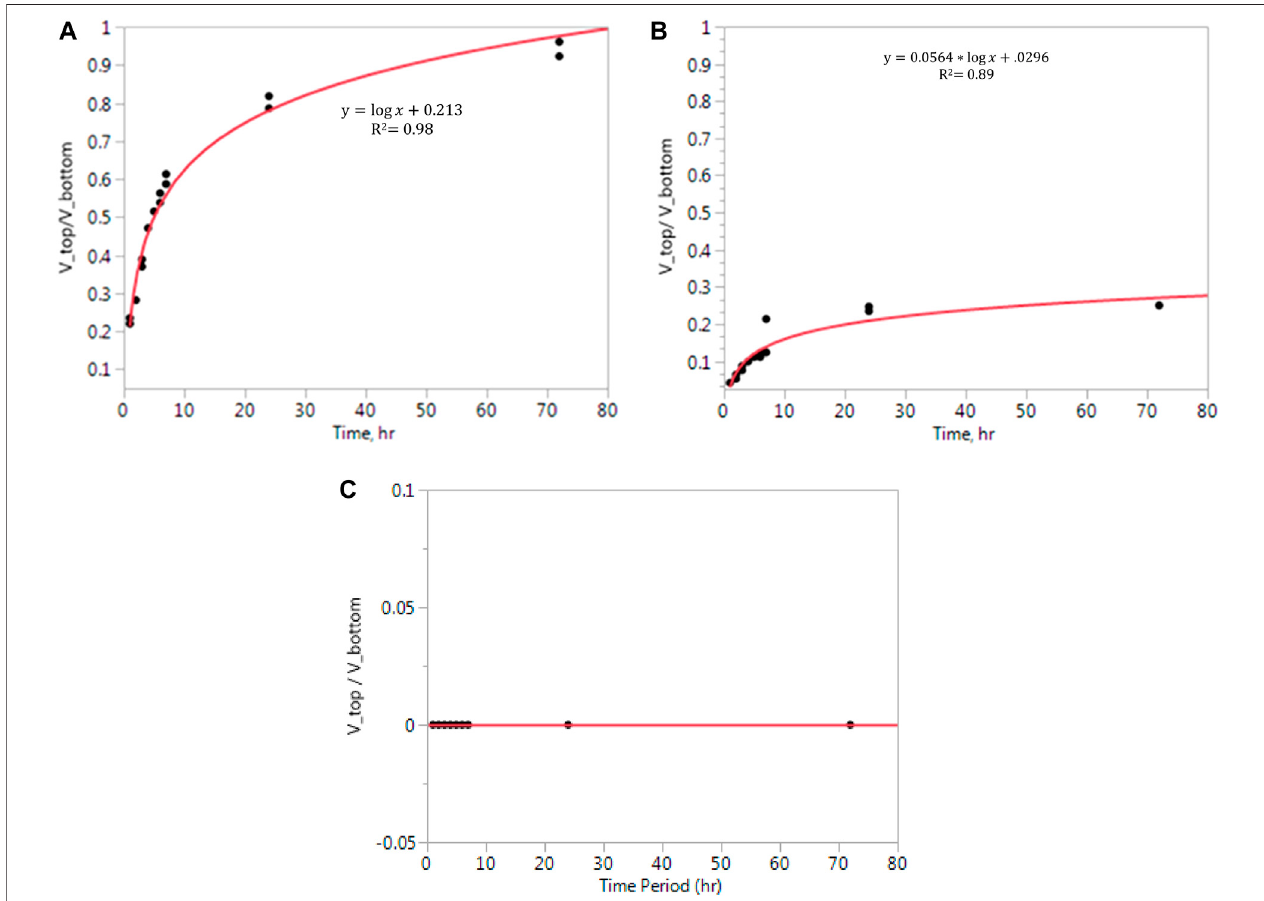
FIGURE 3 | (A) Settling results of V top /V bottom in stillage. (B) Settling results of V top /V bottom in whole stillage. (C) Settling results of V top /V bottom in the syrup sample.